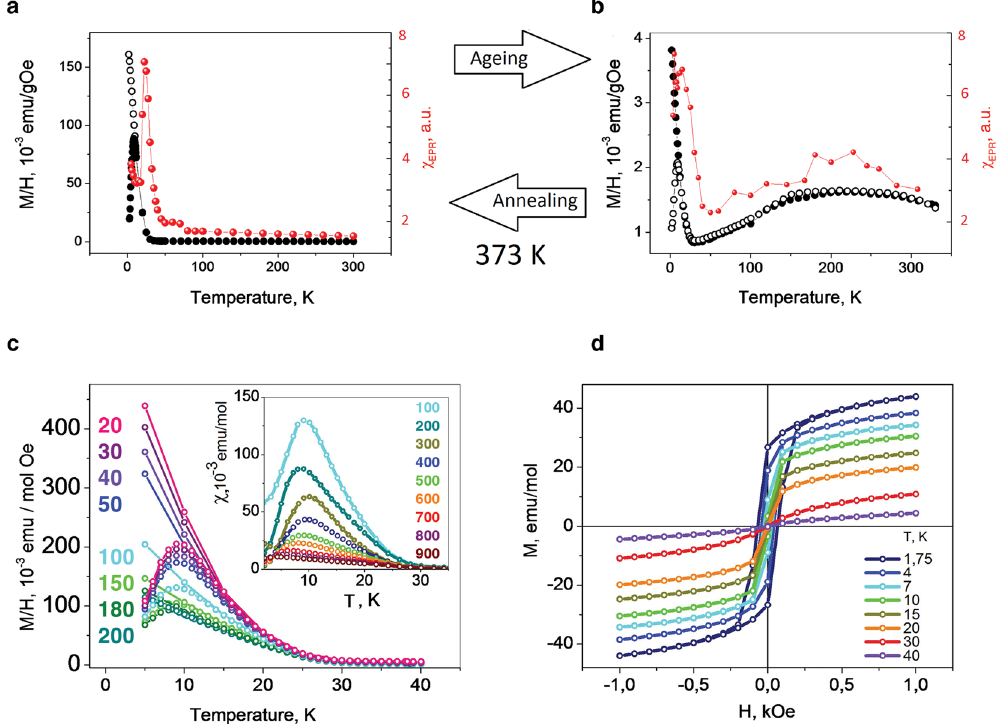
Figure 4. Temperature dependencies of magnetic susceptibility for Tabby graphenes, C 2 F x ( x ≈ 1 ) : ( a ) pristine samples; ( b ) aged samples – the open circles represent the ZFC, the solid circles are the FC measurements, the red symbols represent the double integrated intensity (the EPR susceptibility); ( c ) M( T ) curves taken at different fields; ( d ) M( H ) dependencies taken at different temperatures.